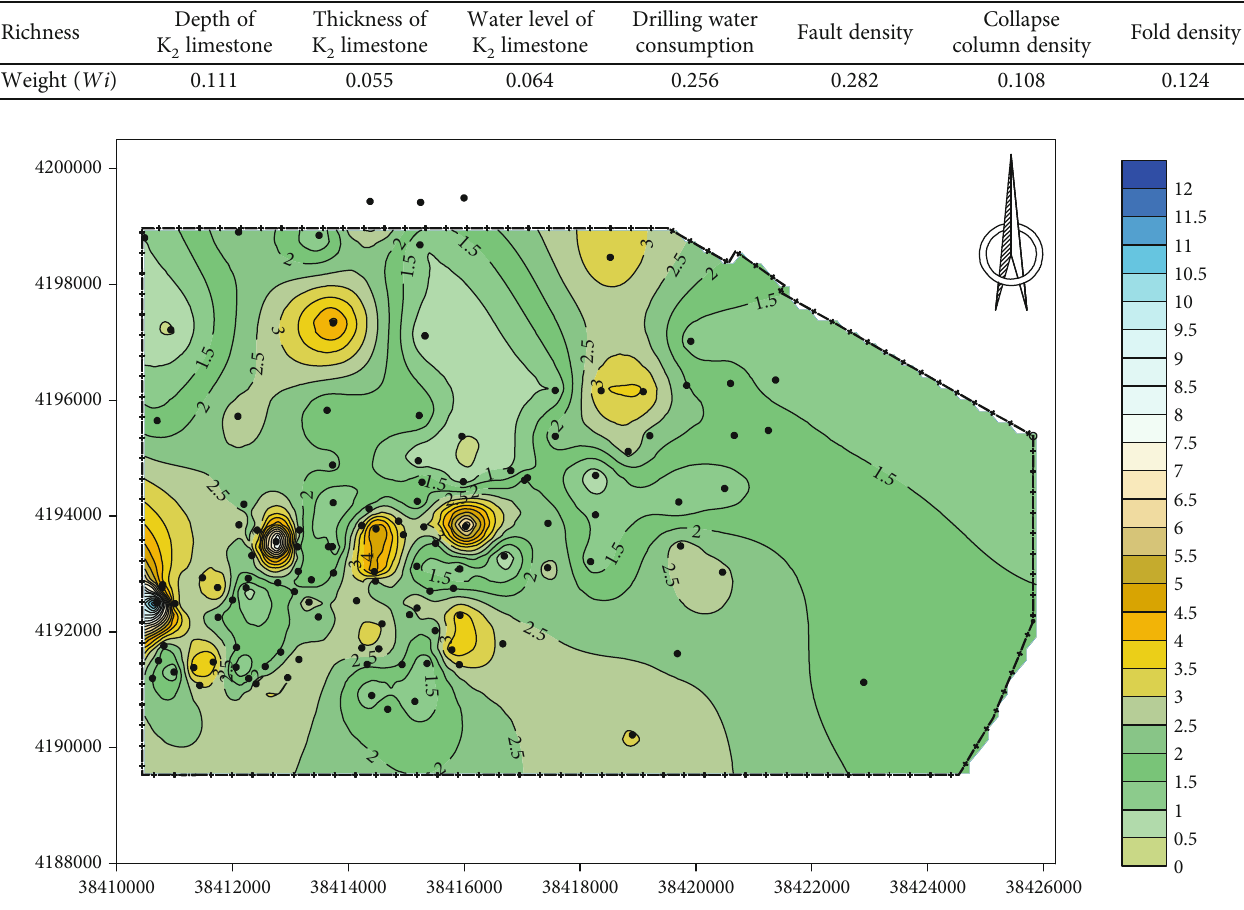
Figure 2: Thematic map of the K